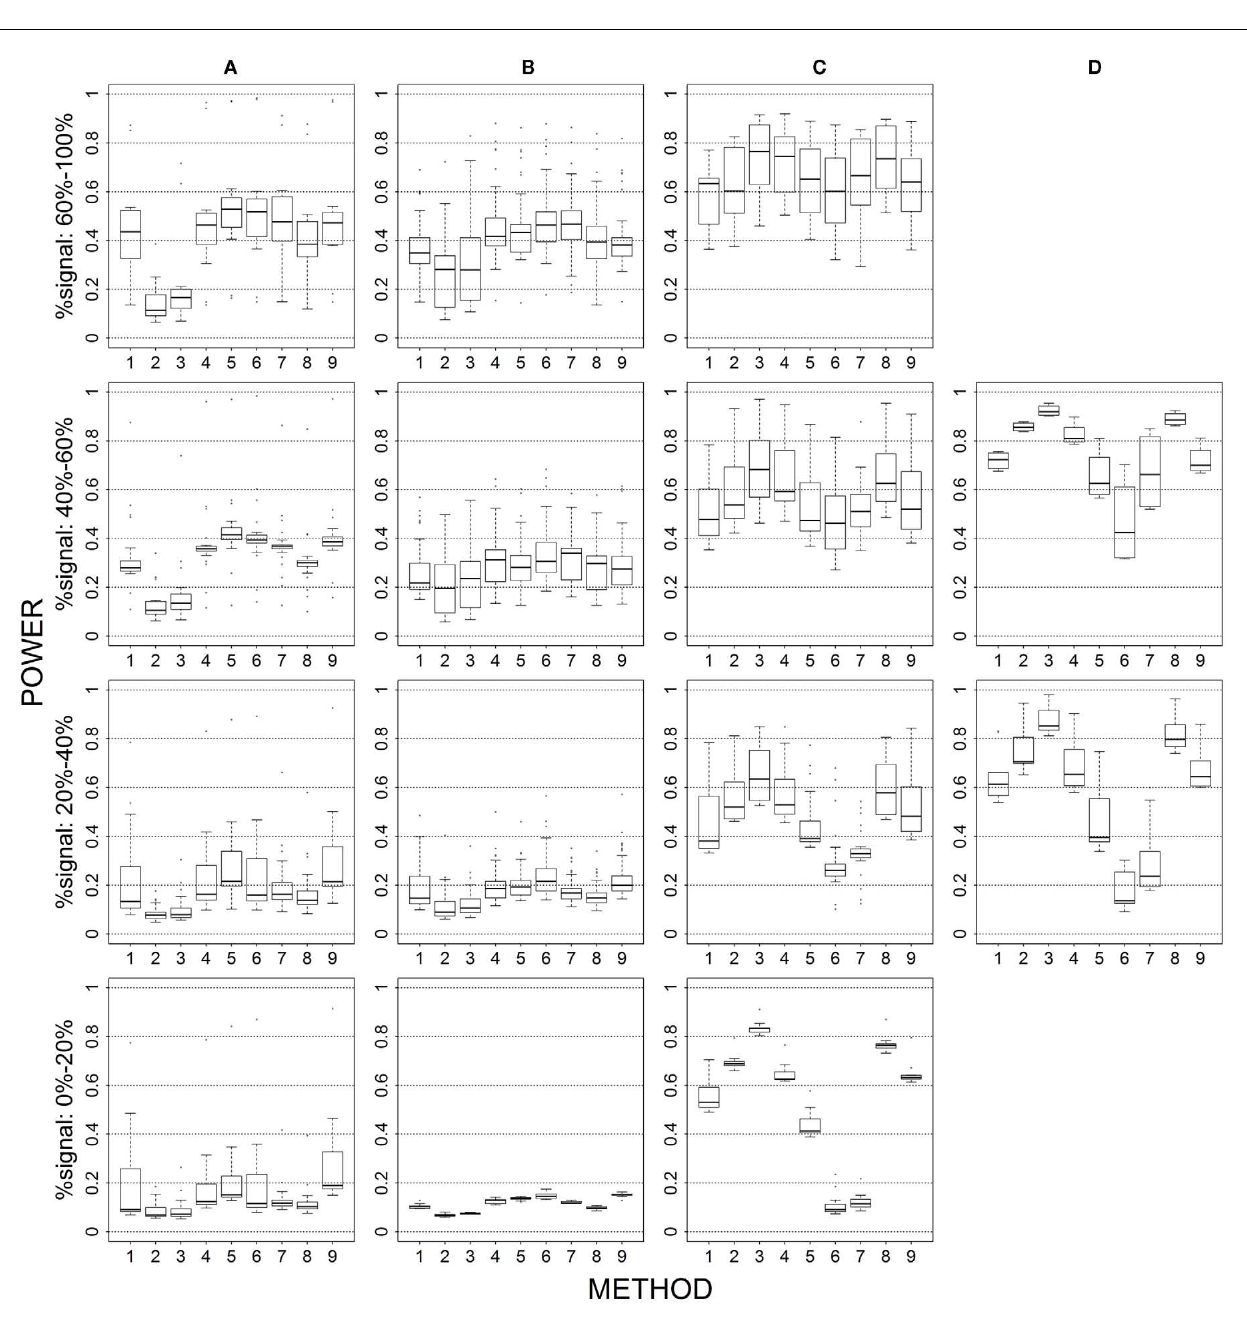
FIGURE 7 | Power results when casual loci have different risk effect sizes under 2 loci out of 30 markers setting for binary trait. Power is calculated over 500 replicate data sets with α = 0.05; there are 435 possible combinations of 2 causal loci out of 30 markers; boxplots summarize the